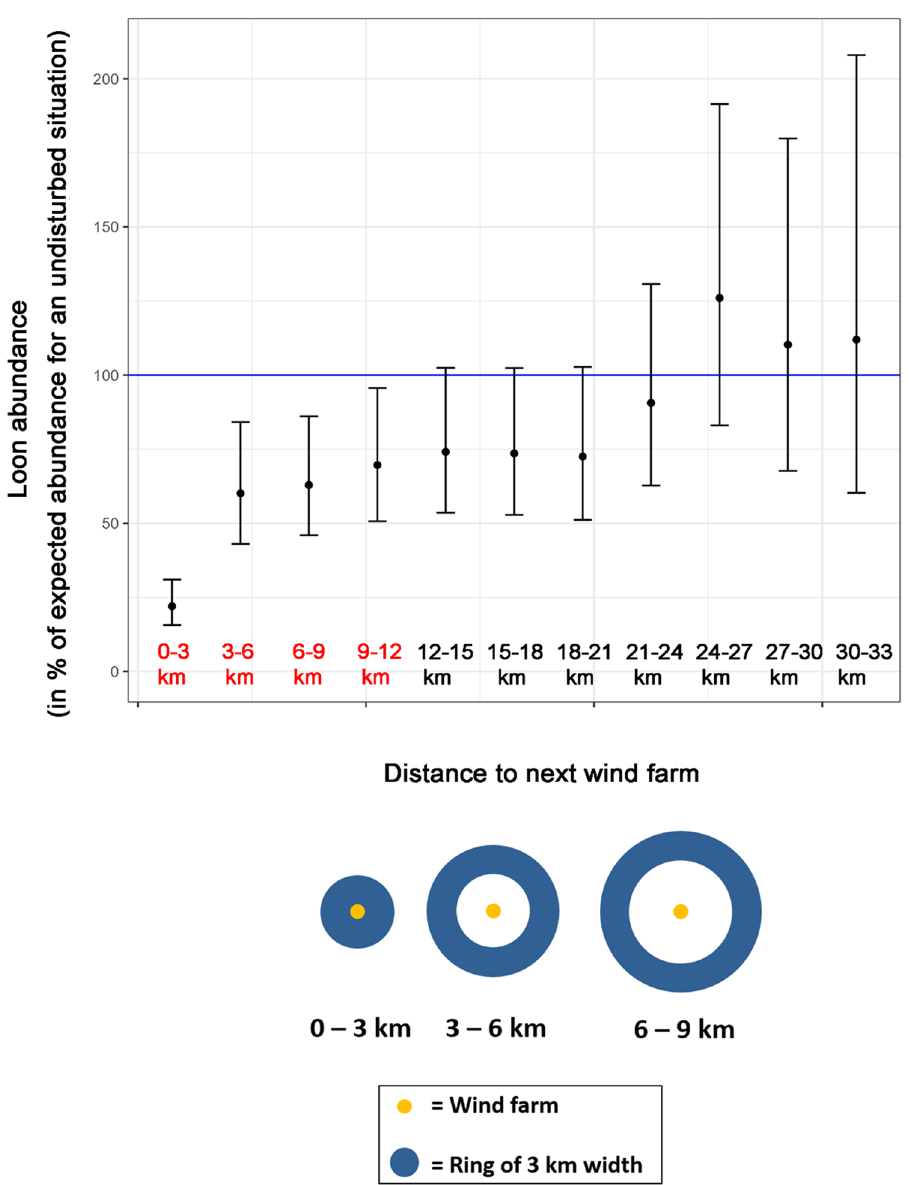
Figure 4. Relative abundances of loons after construction of wind farms in relation to expected abundance without disturbance (100%, blue line). Values shown for steps of 3-km-wide zones (rings) around the wind farms (x-axis); distances in red colour indicate significant reductions of loon abundance. Mean values indicated by dots; 95% confidence intervals indicated by length of